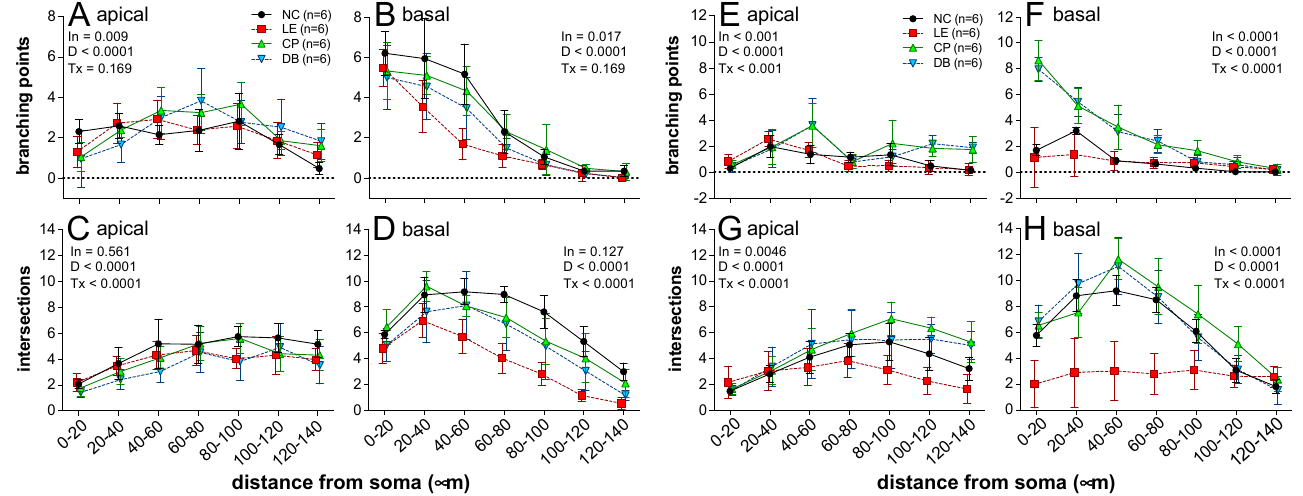
Figure 3. Averaged ( ± SD) apical and basal branching and intersection points for CA1 and CA3 neurons across all the groups for every 20 microns ranging from 20 to 140 µ m. Values from total of 12 hippocampal neurons (CA1 and CA3; in each region, there 2 neurons from n = 6 animals/group). Significance determined using Tukey’s post hoc analysis is denoted by “ln”, which indicates interactions between treatment group (Tx) and distance (D).